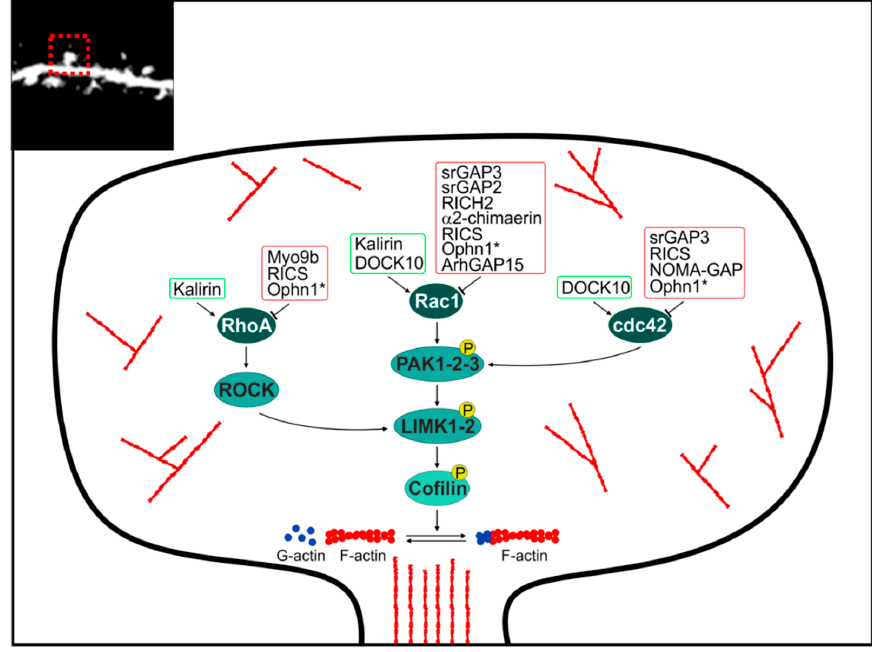
Figure 3. Regulations of Rho GTPases at the dendritic spine of an excitatory synapse, by GAPs and GEFs implicated in Intellectual Disability. Green and red boxes surround GEF and GAP proteins, respectively. Asterisks indicate genes that are mutated in ID and other human diseases comprising ID. Circled P indicates phosphorylation. Arrows indicate activation, T bars indicate inhibition. A representative small magnification image of a dendritic spine is provided in the inset (top left). ROCK, Rho kinase-LIM domain kinase; RICS, Rho GTPase activating protein 32; DOCK10, dedicator of cytokinesis 10; RICH2, Rho GTPase activating protein 44; PAK1-2-3, p21-activated kinase 1-2-3; LIMK1-2, Rho kinase-LIM domain kinase 1-2.